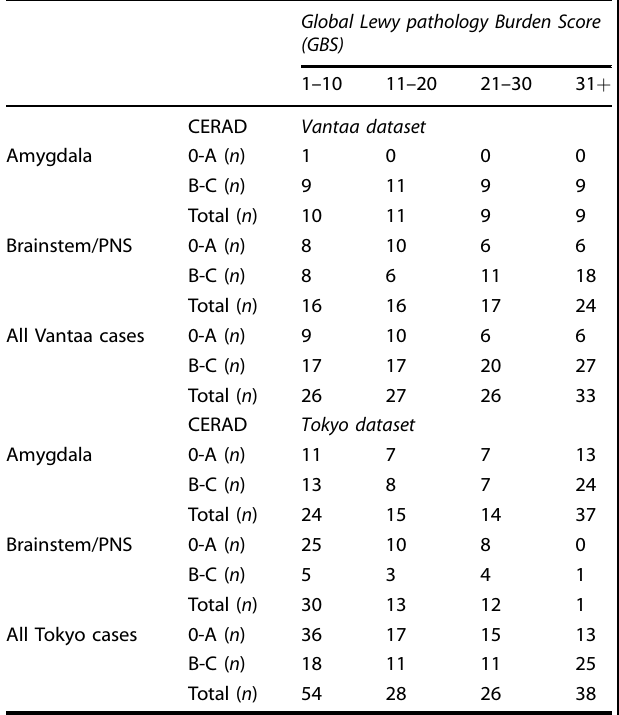
Table 3. Neuritic plaque pathology in Lewy pathology GBS subgroups of the two